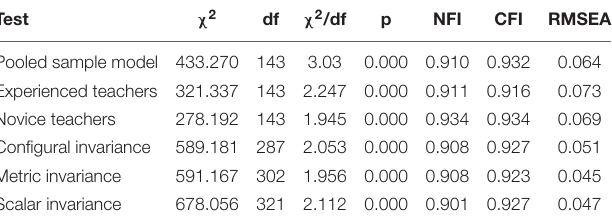
TABLE 5 | Measurement invariance tests for experienced and novice teachers. Test